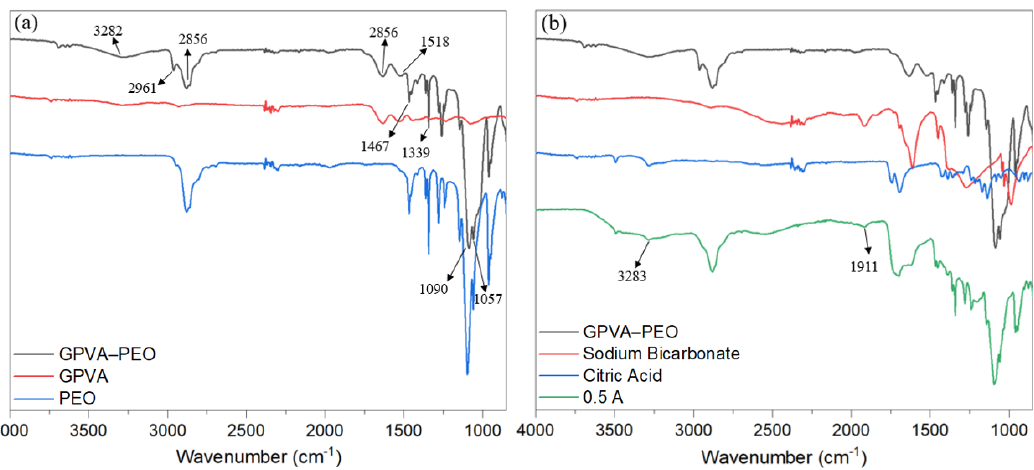
Figure 7. FTIR spectra of ( a ) GPVA-PEO substrate compared to GPVA and PEO ( b ) 0.5A substrate compared to GPVA-PEO, sodium bicarbonate, and citric acid.